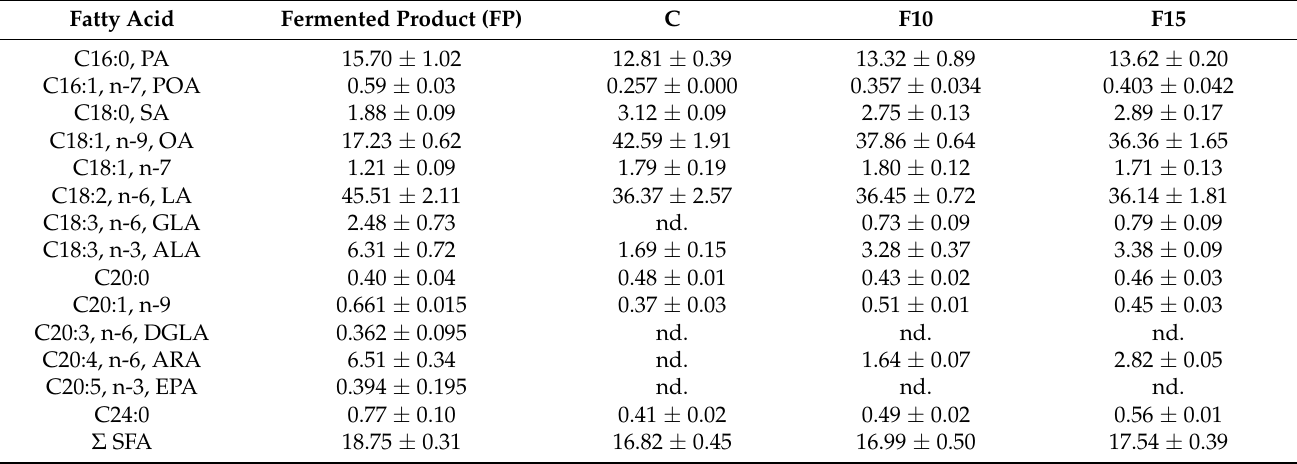
Table 2. Fatty acid profile in laying hens feed